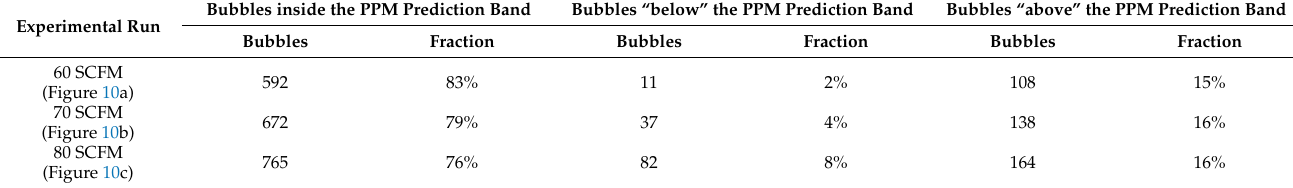
Table 2. Number of bubbles and bubble number fractions with the BRVs and the BACs within the PPM band and number of bubbles and bubble number fractions outside the PPM bands. Note: The sand bed is without biomass pellets. Experimental Run